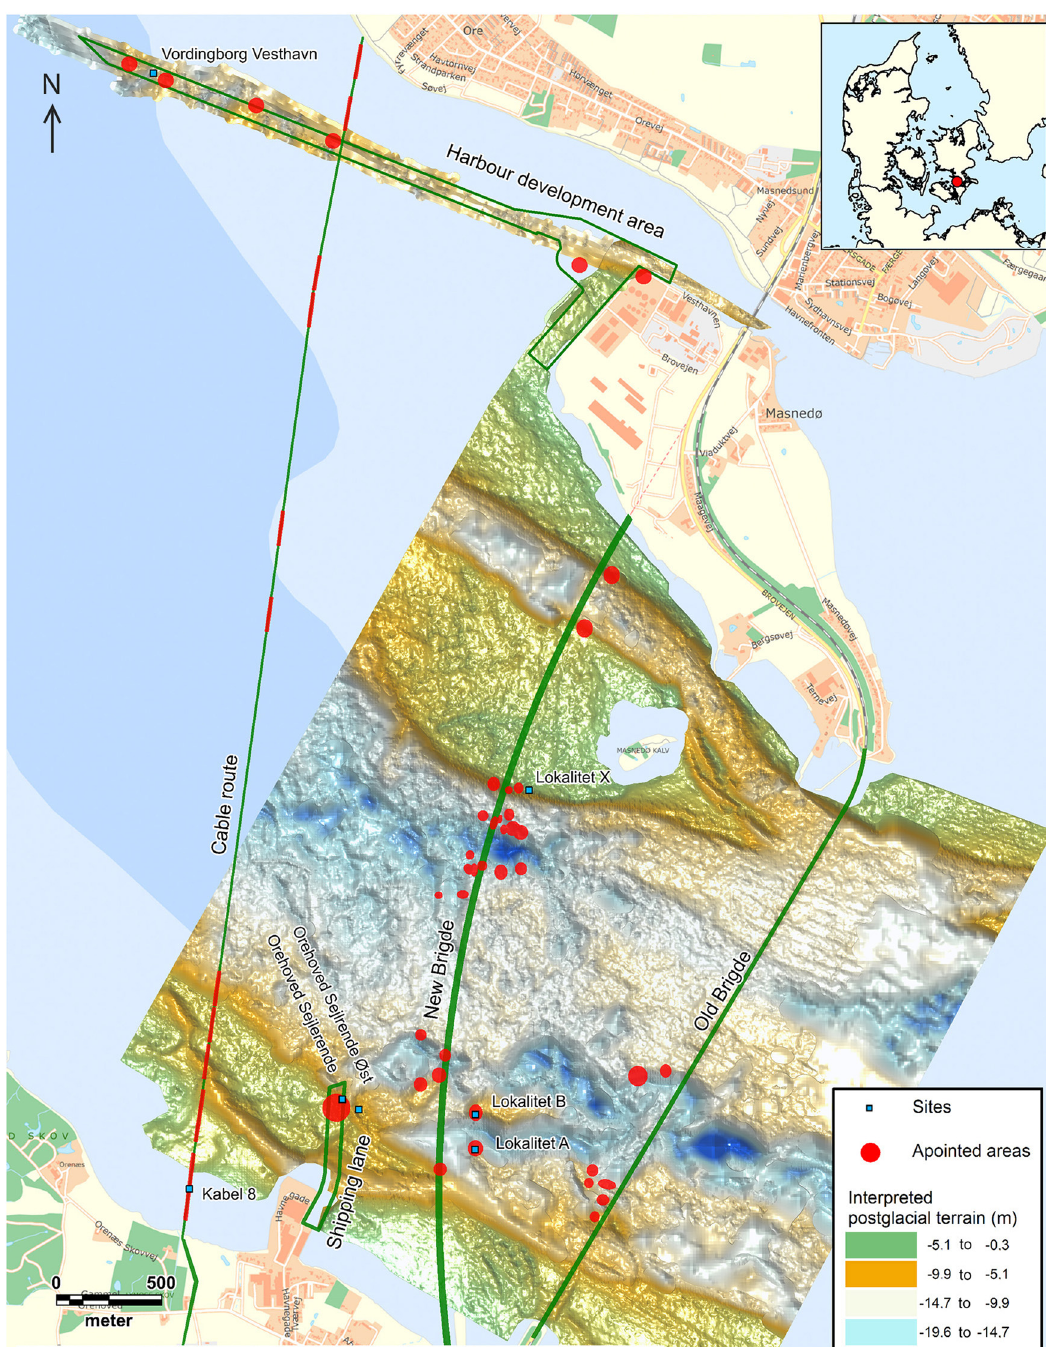
Figure 2: Map showing the interpreted postglacial terrain in the survey area, appointed areas with high potential for preserved Mesolithic sites and sites found during